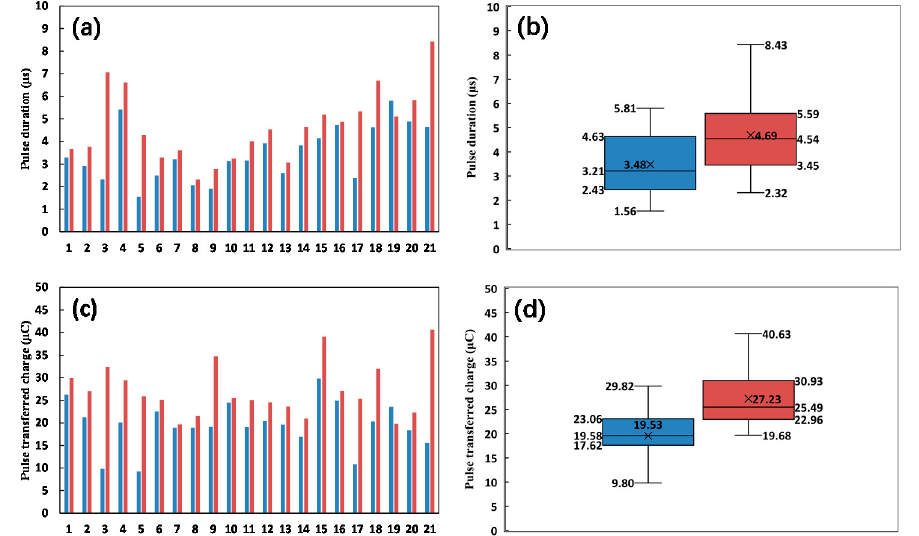
Figure 8. Pulse durations and transferred charges of PCPs when PCP clusters and IPCPs appear. ( a ) Pulse durations during each case. ( b ) Pulse durations for all cases. ( c ) Pulse transferred charges during each case. ( d ) Pulse transferred charges for all cases. The blue is PCP clusters, and the red is IPCPs.